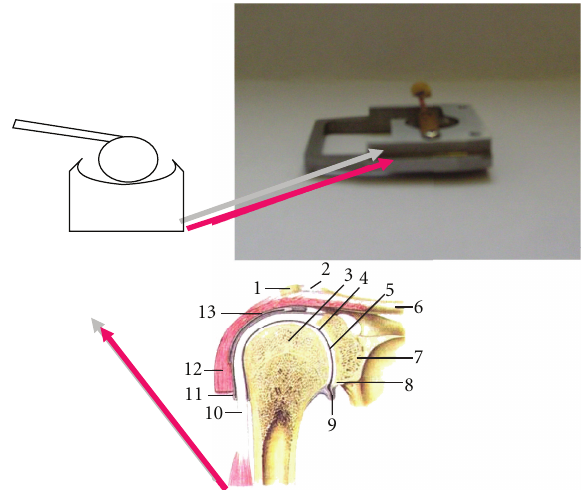
Figure 9: Friction measurement plant scheme.